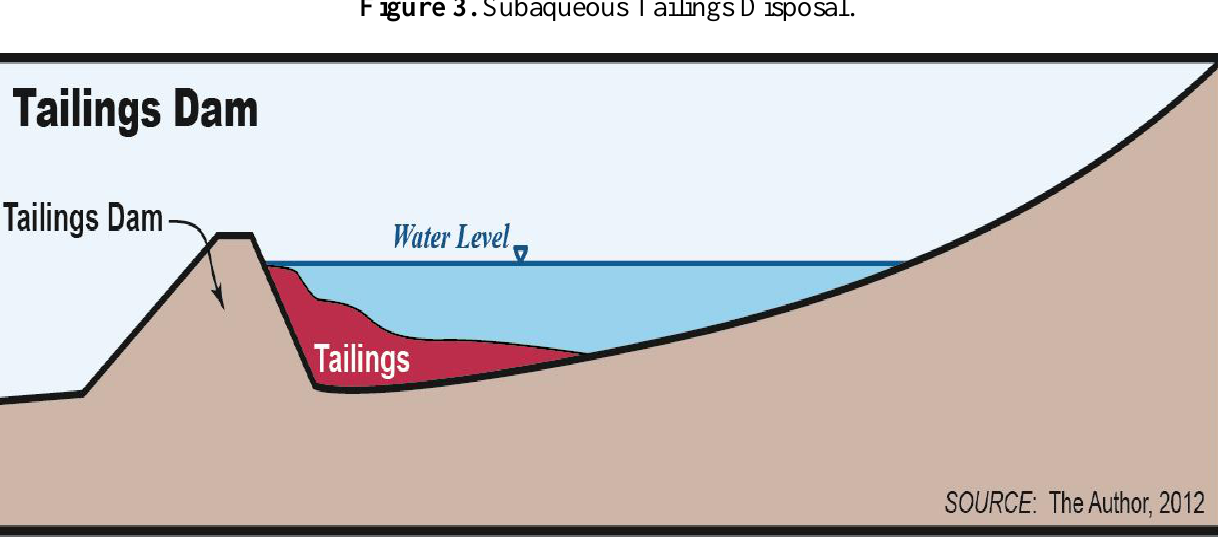
Figure 3. Subaqueous Tailings